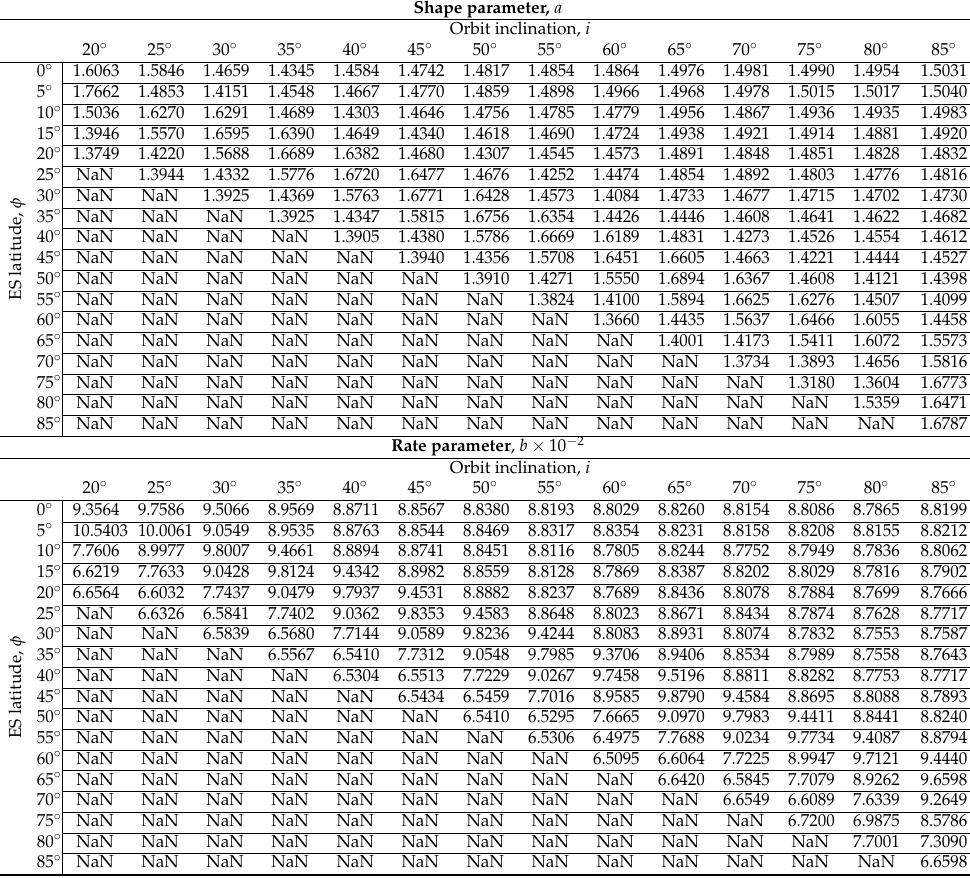
Table A1. Shape, a , and rate, b parameter for f Θ ( θ ) and F Θ ( θ ) for h k = 1000 km.